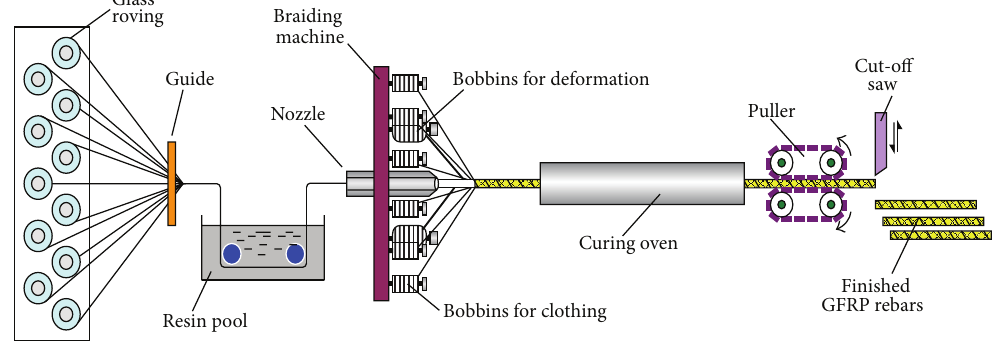
Figure 5: Modified braidtrusion process.